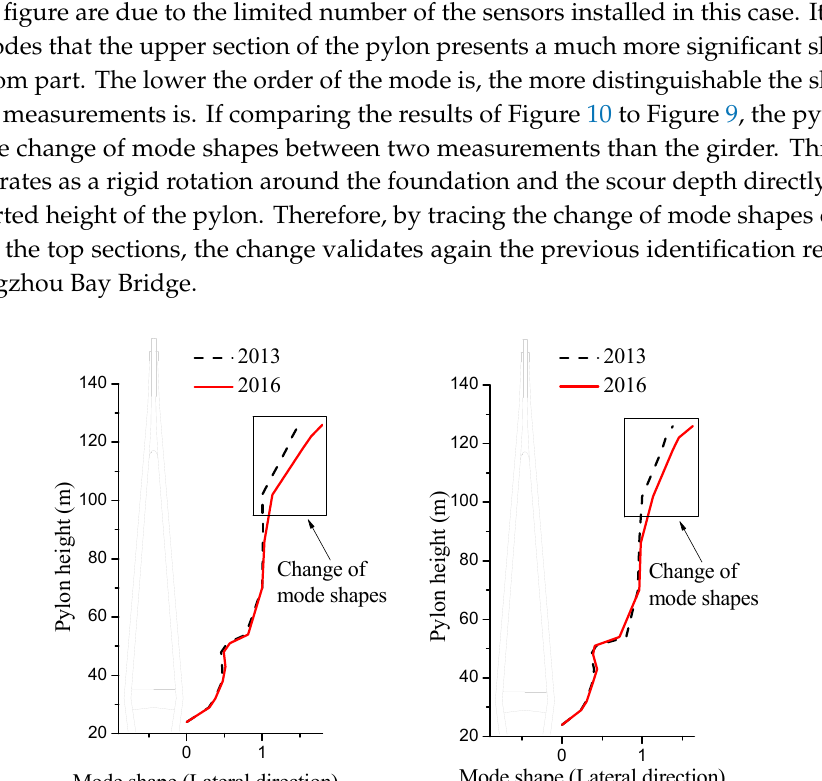
Figure 9. The change of the mode shapes of the girder. ( a ) The 1st vertical bending mode (symmetric), ( b ) The 1st vertical bending mode (antisymmetric), ( c ) The 2nd vertical bending mode (symmetric) ( d ) The 3rd vertical bending mode (symmetric).